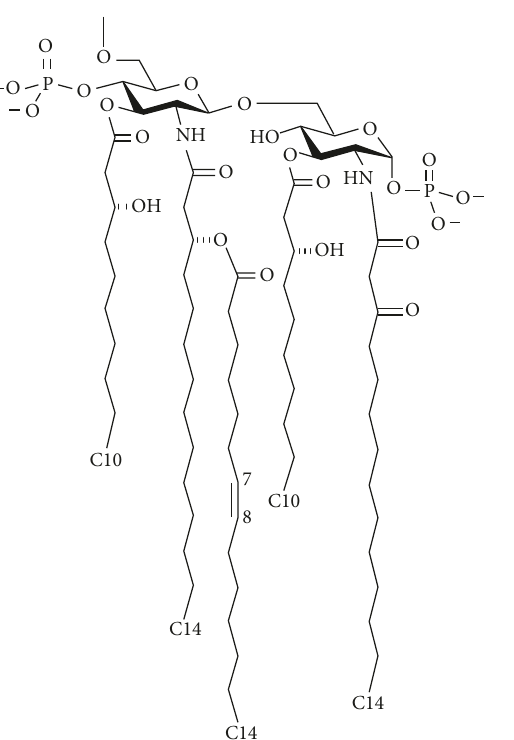
Figure 2: Structure of lipid A from Rhodobacter sphaeroides . Source: [22], under Creative Commons Attribution 4.0 Interna- tional License.